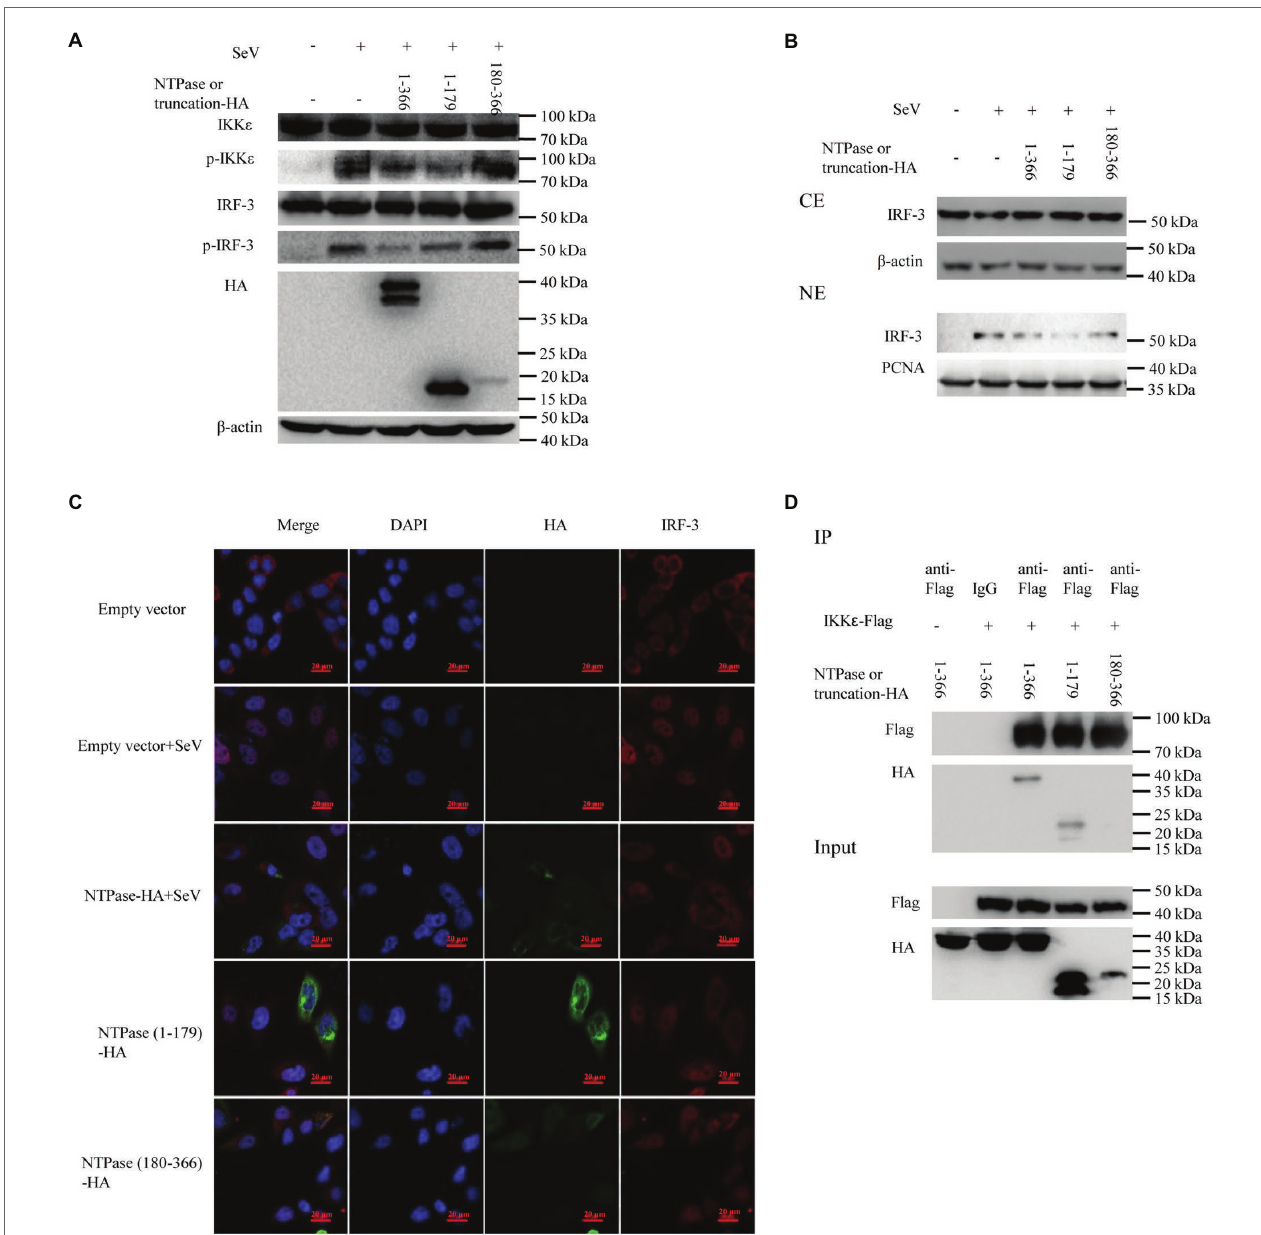
FIGURE 7 | The 1-179 aa domain of NTPase inhibits IFN- β production in the same manner as full-length NTPase. (A) The 1-179 aa domain of NTPase inhibits the phosphorylation of IKK ε and IRF-3 as does full-length NTPases. 3 μ g plasmid expressing HA-tagged NTPase, truncated NTPase, or empty vector was transfected into HEK 293T cells preseeded in 6-well plates. At 24 h posttransfection, cells were stimulated with or without SeV for 16 h. Total protein was isolated. WB was performed to examine IKK ε , p-IKK ε , IRF-3, and p-IRF-3 using corresponding Abs. The expression of NTPase and the truncated NTPase was monitored using anti- HA Ab. (B,C) The 1-179 aa domain of NTPase inhibits IRF-3 nuclear translocation. (B) 3 μ g NTPase, truncated NTPase expression plasmid, or empty vector was transfected into HEK 293T cells preseeded in 6-well plates for 24 h followed by stimulation with or without SeV for 16 h. Cytoplasmic and nuclear proteins were isolated. IRF-3 levels were measured with anti-IRF-3 Ab. β -actin and proliferating cell nuclear antigen were used as loading controls for cytoplasmic and nuclear proteins, respectively. (C) 3 μ g HA-tagged NTPase, truncation expression plasmid, or empty vector was transfected into HeLa cells preseeded in 35-mm dishes. At 24 h posttransfection, cells were stimulated with or without SeV for 16 h. Cells were incubated with mouse anti-HA Ab and rabbit anti-IRF-3 pAb, followed by Alexa Fluor 488-labeled Goat Anti-Mouse IgG (H + L) (green) and Alexa Fluor 647-labeled Goat Anti-Rabbit IgG (H + L) (red) as the secondary Abs. Cell nuclei (blue) were stained with DAPI. The images were acquired by fluorescence microscopy using a 60 × objective. One representative experiment out of three is shown. (D) The 1-179 aa domain of NTPase interacts with IKK ε as does full-length NTPases. HEK 293T cells in 6-well plates were cotransfected with 1.5 μ g HA-tagged NTPase or truncated NTPase expression plasmid together with 1.5 μ g plasmid expressing Flag-tagged IKK ε or empty vector for 40 h. A mouse anti-Flag Ab was used for Co- IP of cell lysates with normal IgG being used as a negative control. Co-IP products and 5% input samples were examined using rabbit anti-HA and mouse anti-Flag Abs with WB. One representative experiment out of three is shown for WB. CE, cytoplasmic protein extract; NE, nuclear protein